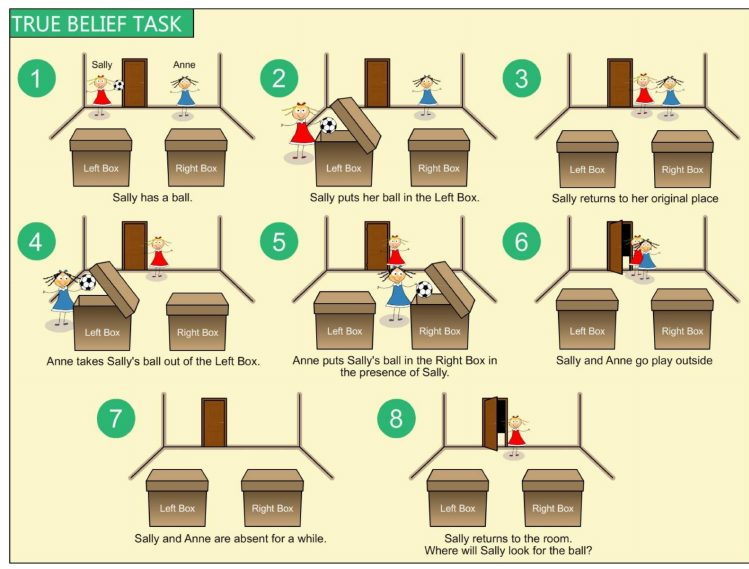
Figure 2. Sequence of the stimuli of the true belief